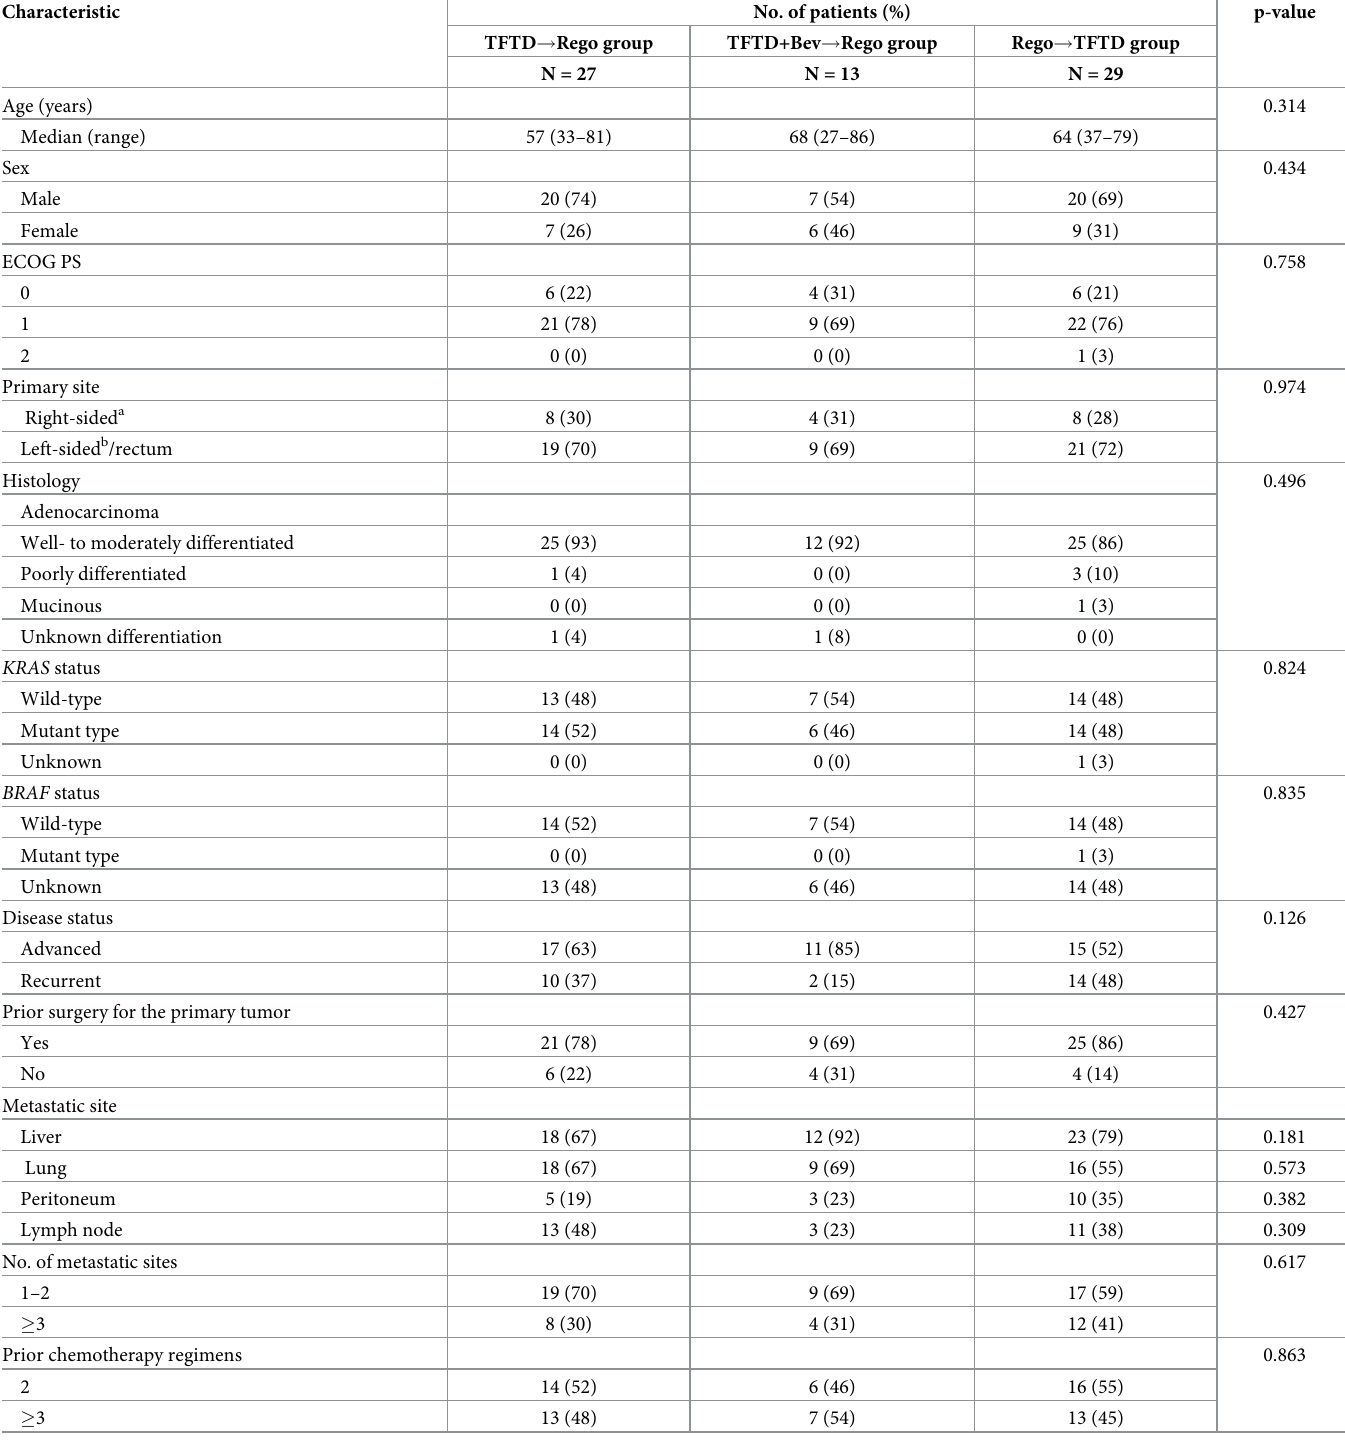
Table 1. Patient